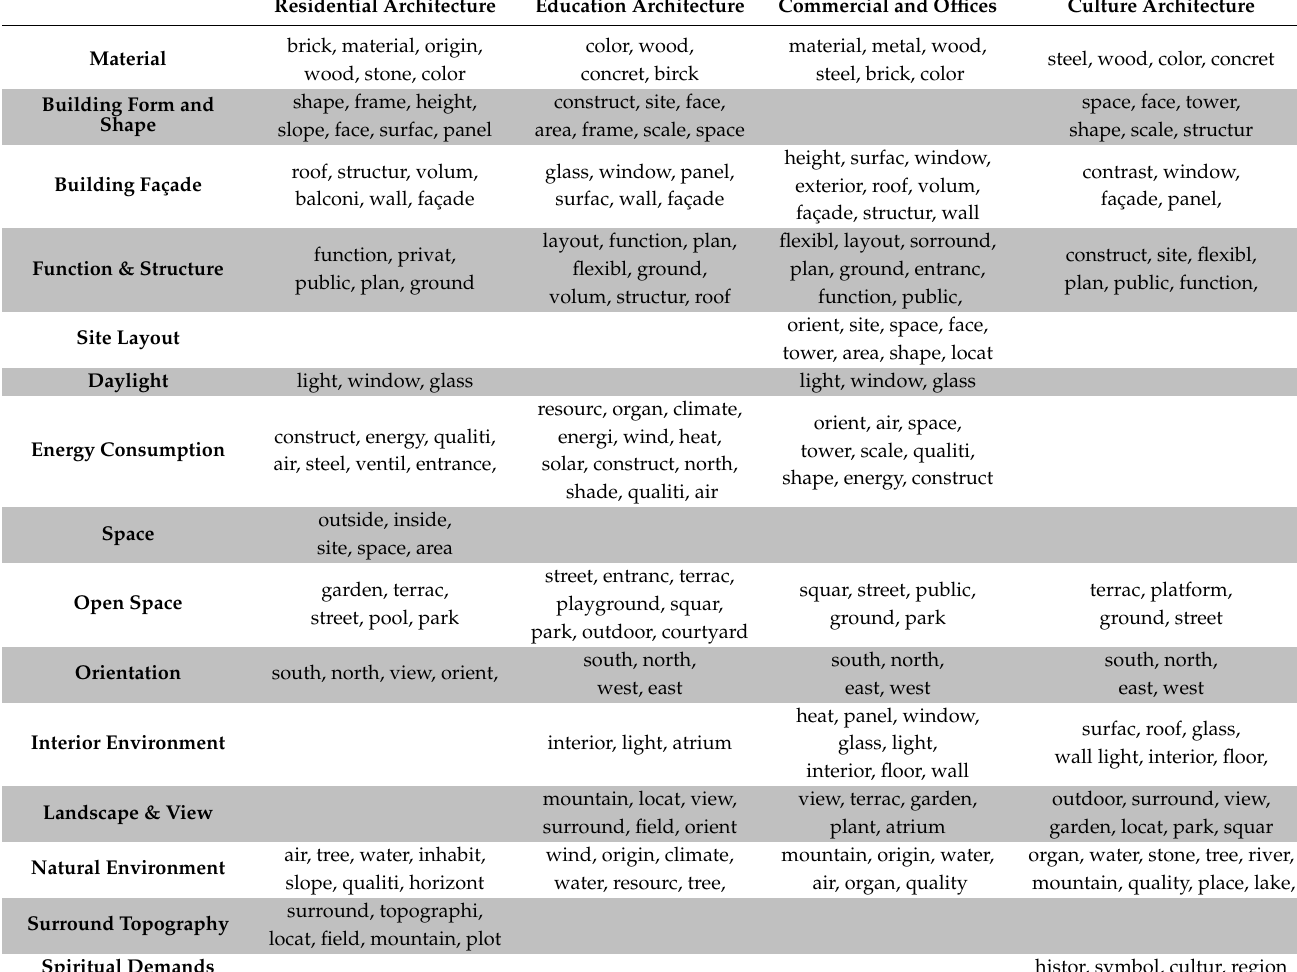
Table 3. Summary of design elements in the four building